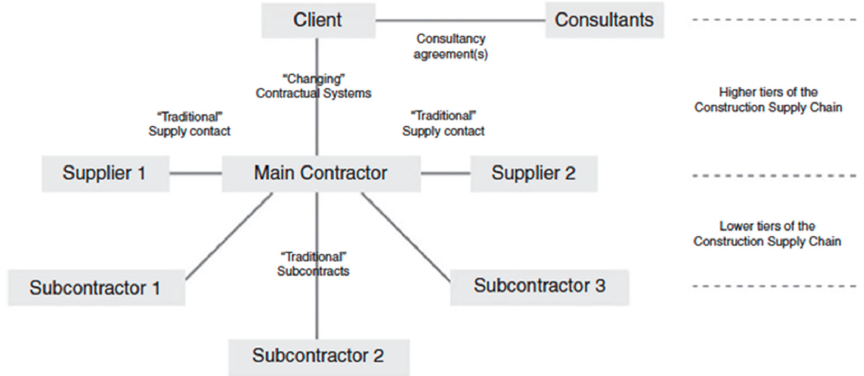
Figure 1. Current procurement structure (Broft et al. [33]; reprinted with permission: Emerald).